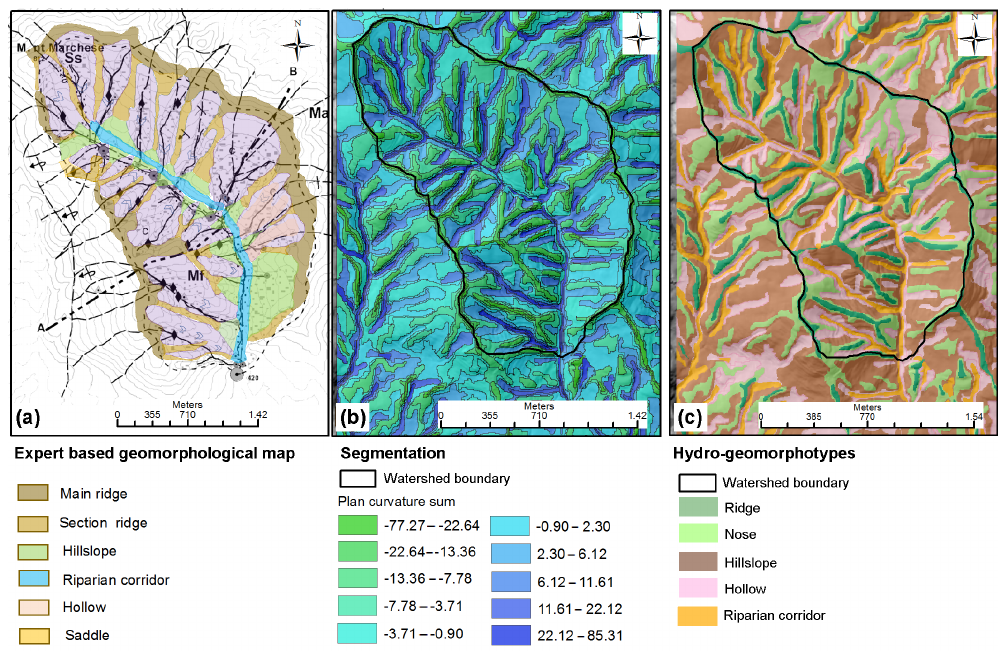
Figure 7. (a) Expert-based hydro-geomorphological map; (b) multiresolution segmentation map; (c) object-based hydro-geomorphological map obtained by classifying the multiresolution segmentation map using the plan curvature sum only.